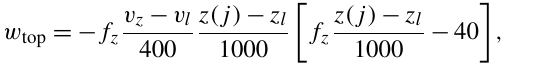
formula for a circle on the lower